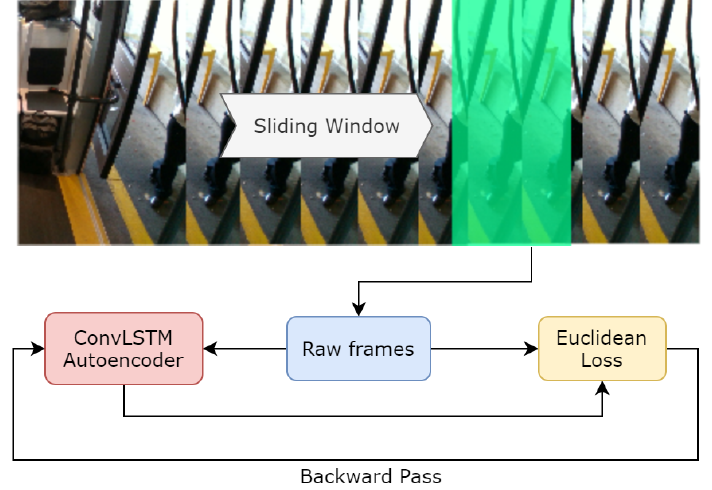
Figure 11. Preprocessing using a sliding window of 10 frames and training pipeline. Euclidean loss is used to learn